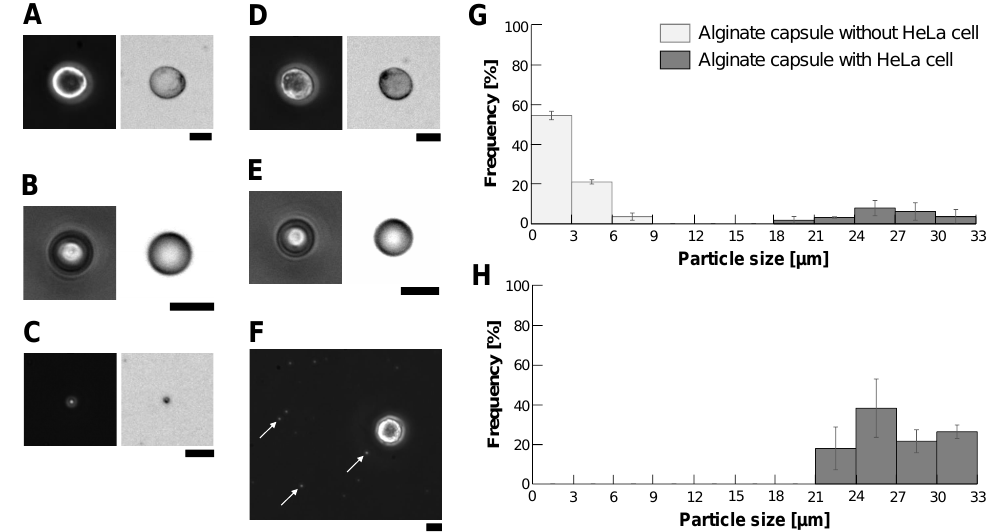
Figure 5. Micrographs of empty and filled alginate microcapsules and their filtration results. ( A – E ), Left: Phase-contrast image, Right: Bright-field image. ( A ): HeLa cell, ( B ): 10µm fluorescent polystyrene microbead, ( C ): Empty alginate microcapsule, ( D ): HeLa cell-encapsulated alginate microcapsule, ( E ): 10µm microbead-encapsulated alginate microcapsule. ( F ): Mixture of empty and HeLa cell-encapsulated alginate microcapsules acquired from sodium alginate buffer containing HeLa cells using a 4000 rpm centrifugation method. Arrows indicate the empty alginate microcapsules. Bars, 10µm. ( G ): Size distribution of the mixture of empty and HeLa cell-filled alginate microcapsules using the 4000 rpm centrifugation method. Filled bars, the ratio of alginate microcapsules containing HeLa cells and open bars, the ratio of empty alginate microcapsules, respectively. ( H ): Size distribution of particles after filtration of alginate microcapsules with 20µm cell strainer (n =